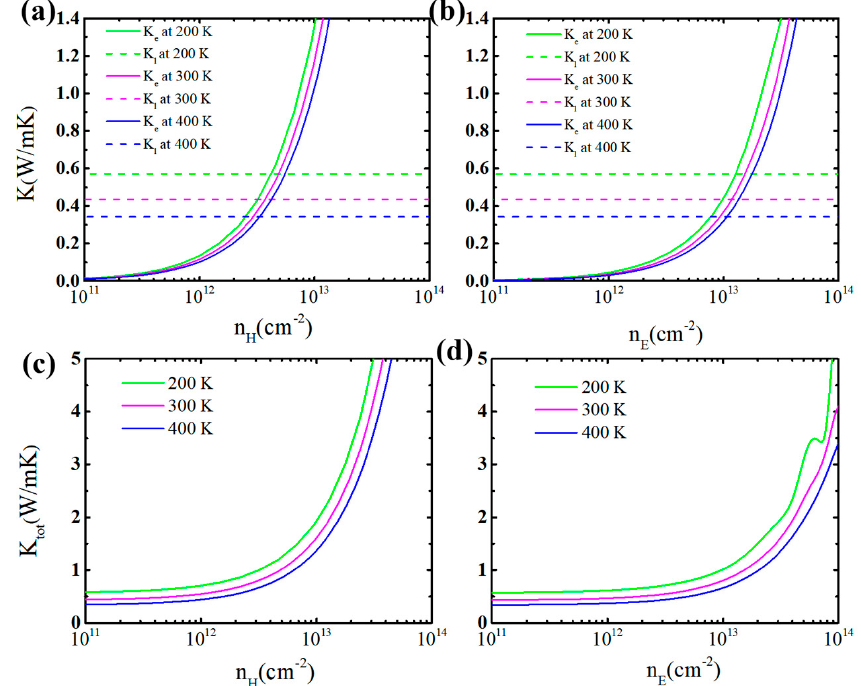
Figure 4. The electron ( κ e ) and phonon ( κ l ) thermal conductivity ( a , b ) as well as the total ( κ tot ) thermal conductivity ( c , d ) with the change of carrier concentration and temperature for monolayer GeP 3 . The left (right) part represents the p -type ( n -type) doping.